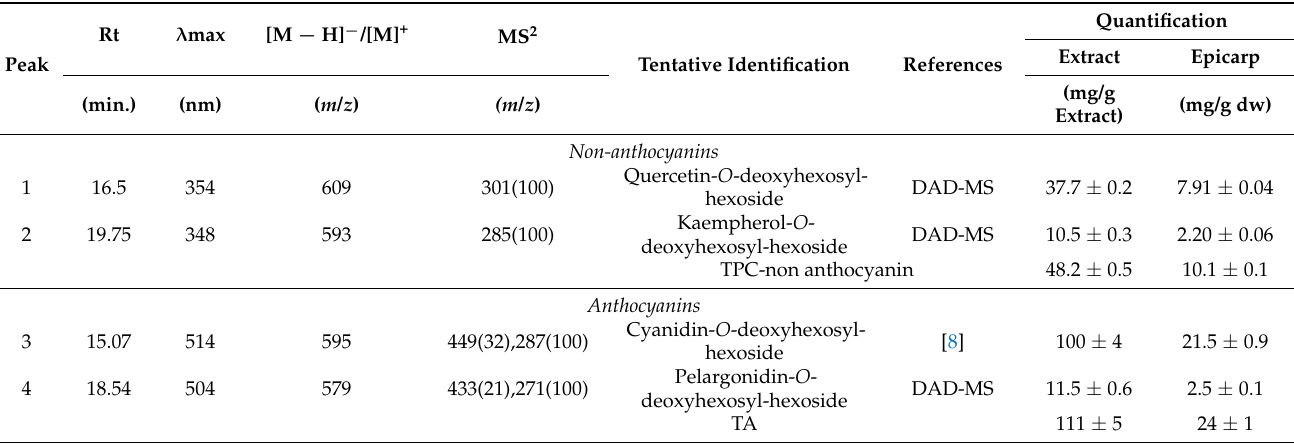
Table 2. Retention time (Rt), wavelengths of maximum absorption in the visible region ( λ max), mass spectral data, tentative identification, and quantification estimation of compounds in S. odorifera epicarp.